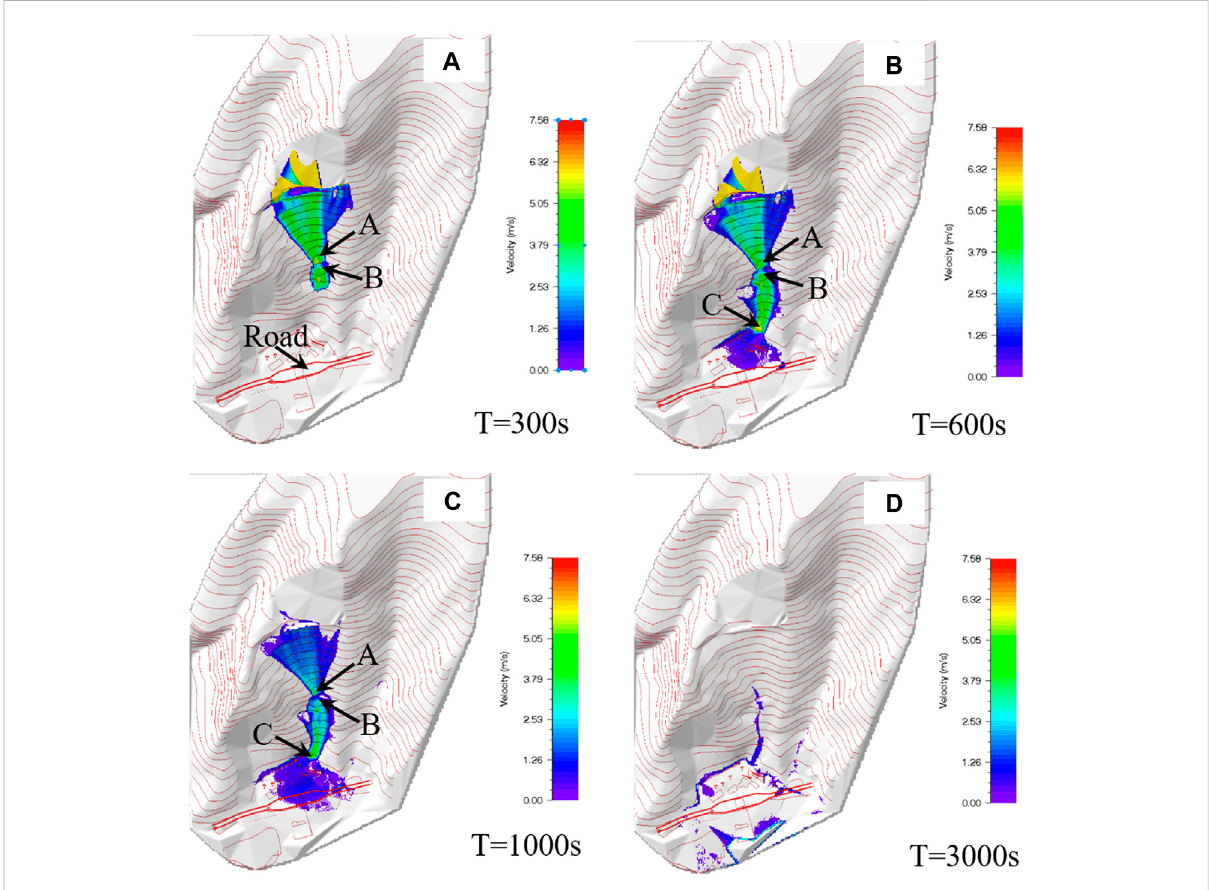
FIGURE 5 Variationofthe fl owvelocityofdebrisontheslopesurfaceundertheconditionofextemerainfallonceevery20 yearsat (A) t =150 s, (B) t =600 s, (C) t =1,000 s, and (D) t =3,000